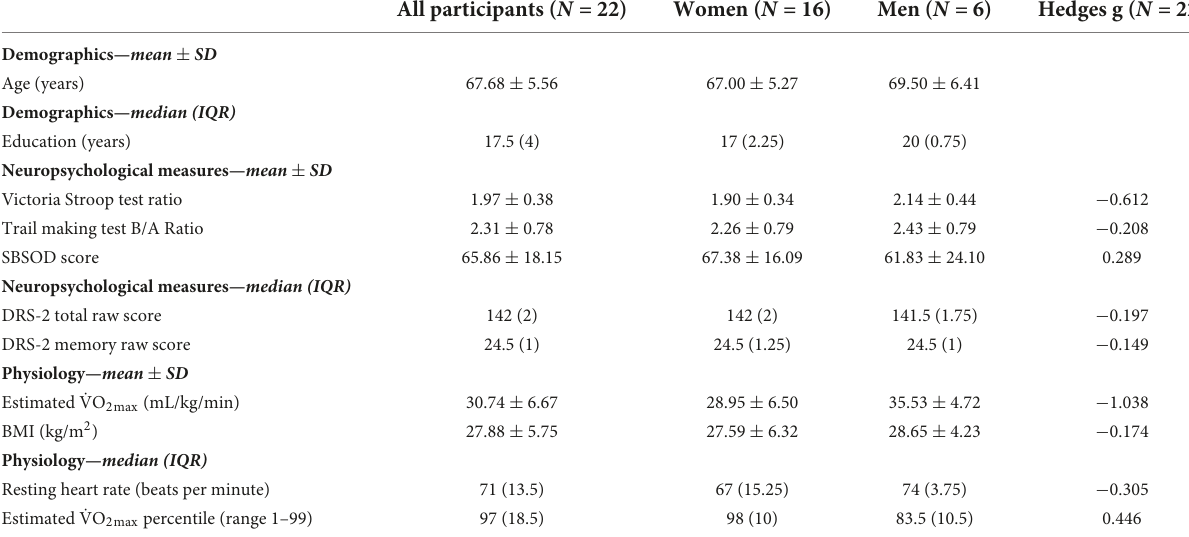
right and left isthmus of the cingulate cortex (retrosplenial cortex), right precuneus, right and left inferior parietal cortex, right and left cerebellum in lobule VIIa Crus I and II, right fusiform gyrus, right parahippocampal gyrus (and more specifically, the parahippocampal cortex), right lingual gyrus, and right hippocampus ( Table 2 and Figure 3 ).